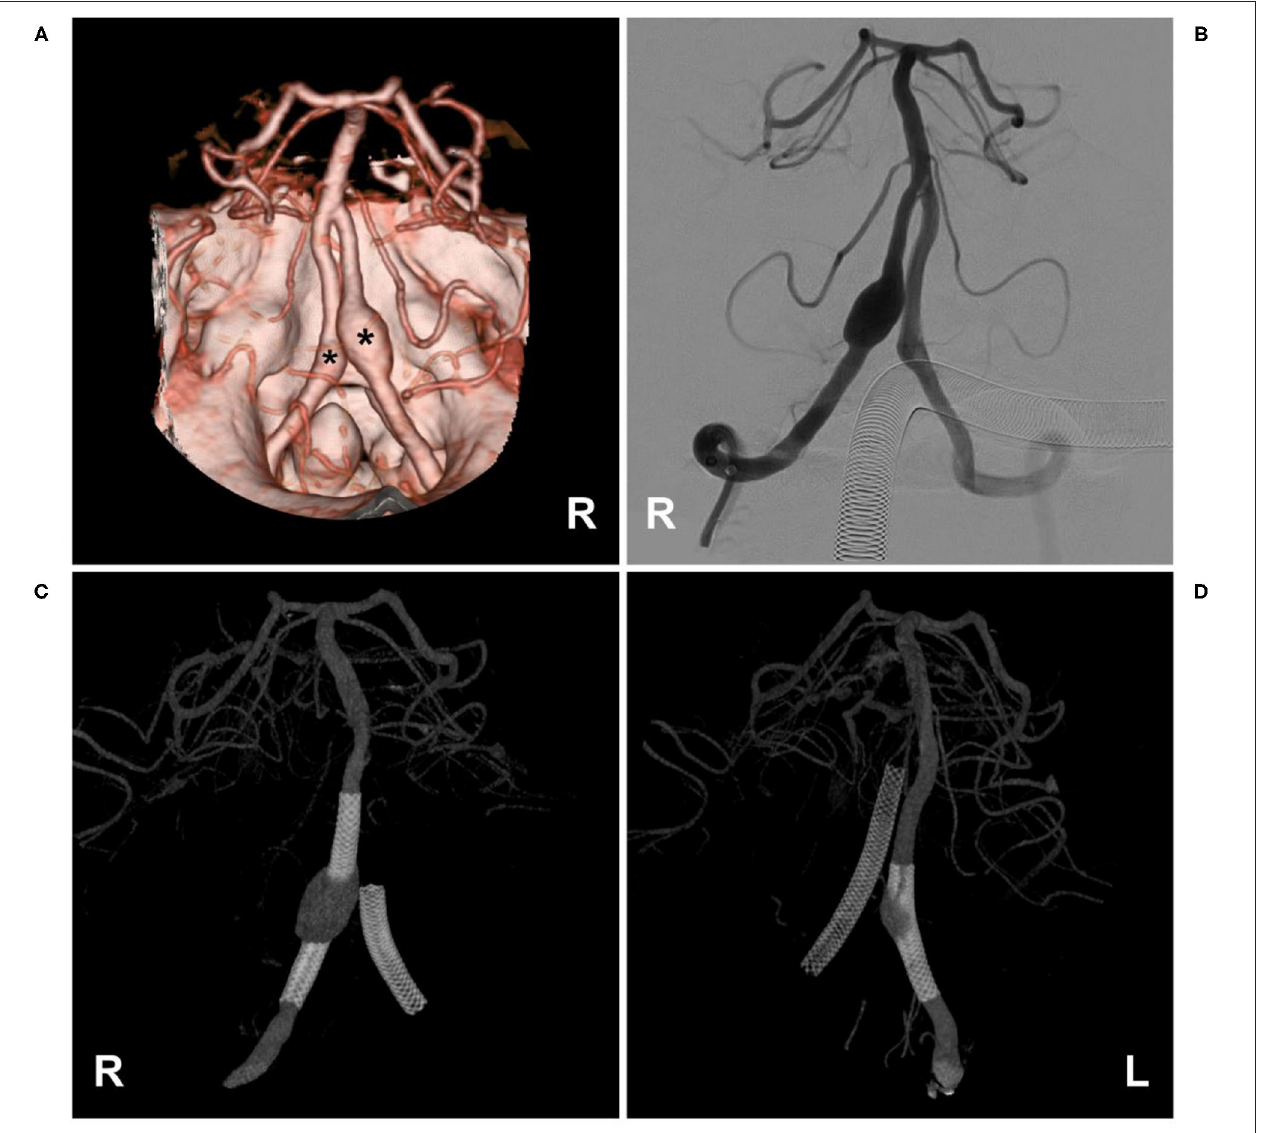
FIGURE 6 | Flow diversion deployment to treat bilateral VA aneurysms. (A,B) CTA (A) and VA angiogram (B) showing bilateral VA dissecting aneurysms (asterisks in (A) ); in (B) , the ASA was not observed. (C,D) Angiogram of the bilateral VA showing the flow diversions deployed to treat the aneurysms. ASA, anterior spinal artery; CTA, computed tomography angiography; L, left; R, right; VA, vertebral artery.